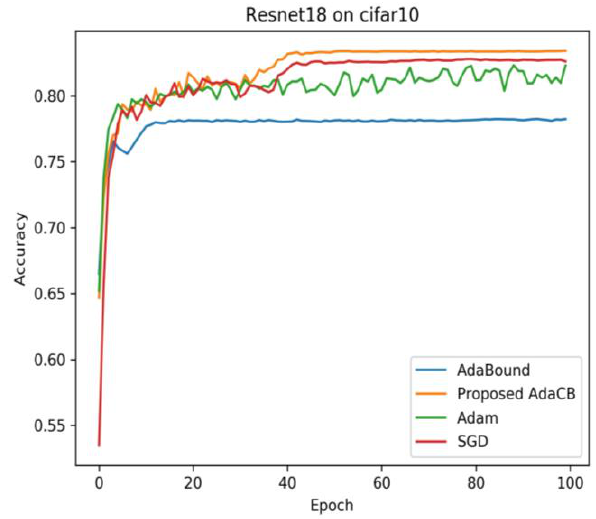
Figure 6. The learning curve of testing accuracy on CIFAR10 under Resnet18.